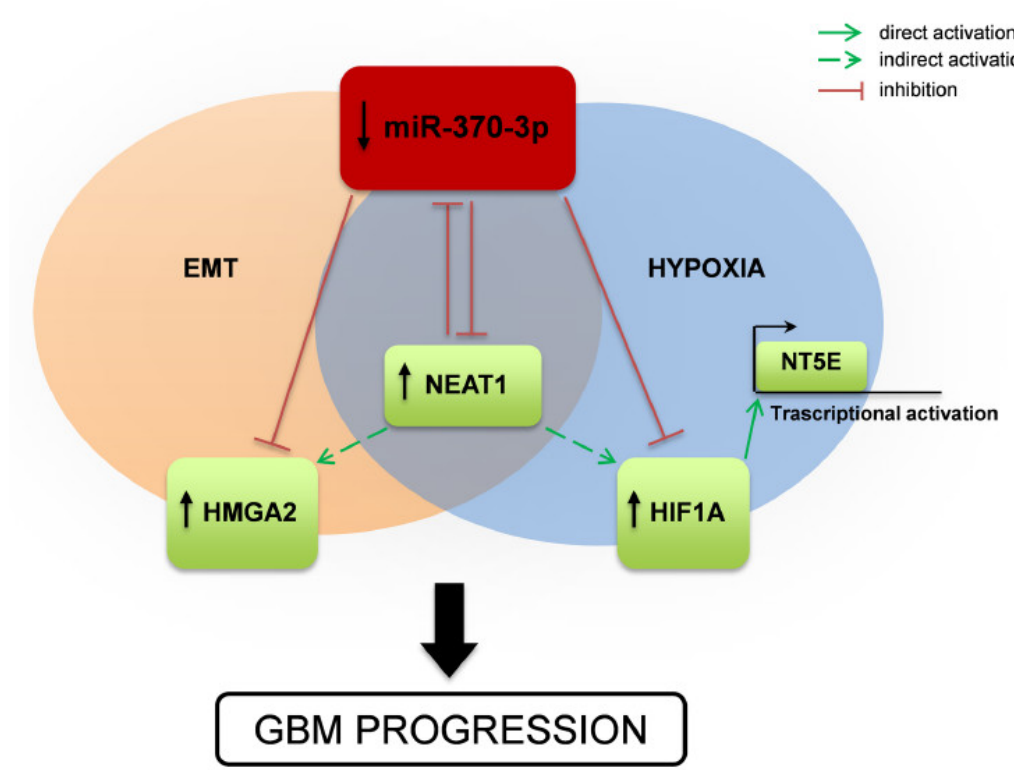
Figure 7. Schematic drawing of miR-370-3p regulation of HMGA2-HIF1A-NEAT1 interplay and effect on GBM tumorigenesis. Representation of the mechanism proposed in the present study. miR-370-3p down-regulation leads to increased expression of the lncRNA NEAT1, the Epithelial to Mesenchymal Transition (EMT)-inducer HMGA2, the master transcriptional regulator HIF1A, which in turn activates NT5E expression. NEAT1 inhibits the expression of miR-370-3p, promoting the up-regulation of HMGA2 and HIF1A and contributing to GBM progression.